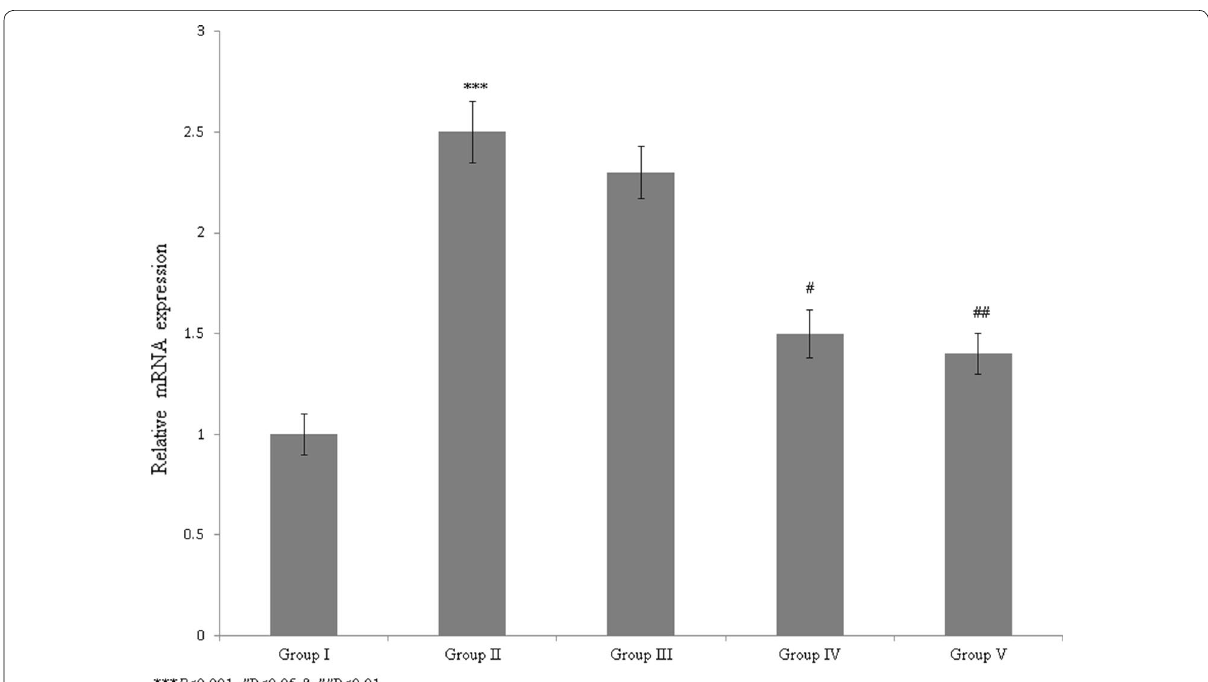
Fig. 4 The protective effect of a T. portulacastrum extract on mRNA expression of GPR124 in normal diabetic rats. *** P < 0.001 vs. sham; # P < 0.05 and ## P < 0.01 vs. control. N 6 =